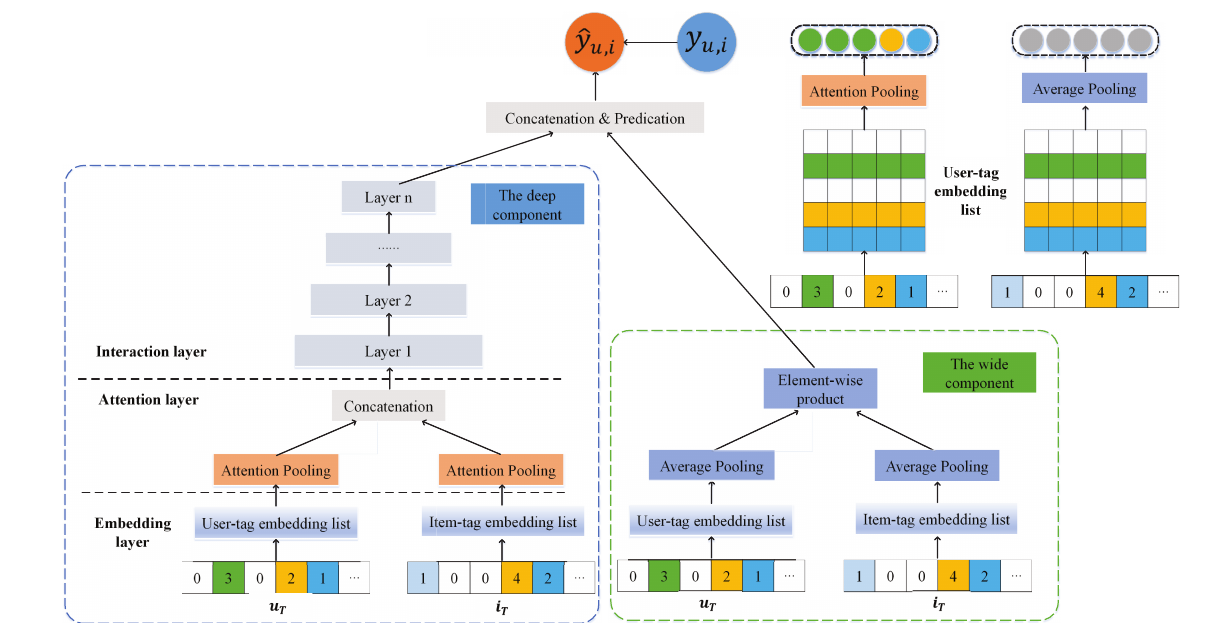
Figure 2. The overall structure of the proposed model. The upper right corner illustrates the difference between average pooling and attention pooling. The weights of different feature vectors are set to the same value in average pooling, while these weights will be automatically learned according to their importance in attention